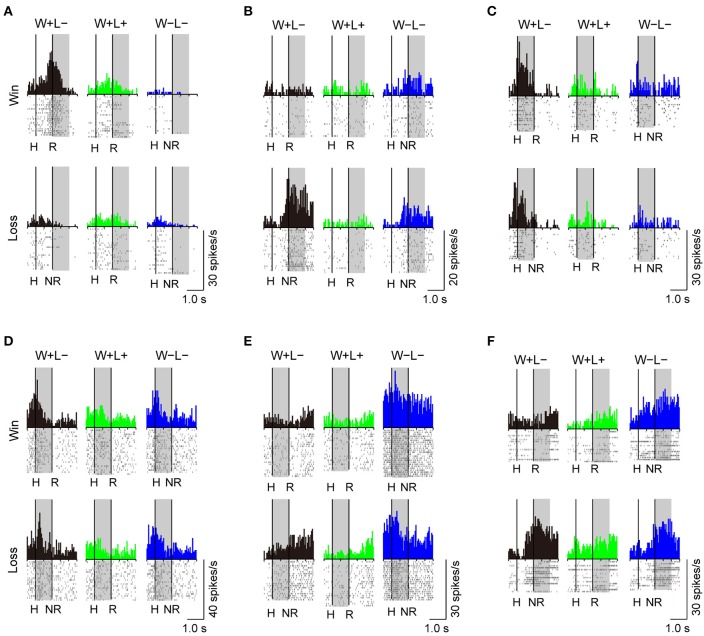
Examples of LPFC neurons that showed differential activity depending on the trial type. (A) positive Win/Lose x Black, (B) negative Win/Lose x Black, (C) positive Black, (D) negative Green, (E) positive Blue, and (F) negative Reward type neurons (“positive” and “negative” indicate neurons with positive and negative beta values, respectively. See Materials and Methods). The left vertical line in each display indicates the time of a hit by either monkey. The right vertical line indicates either the time of a reward delivery (reward trials) or 1 s after a hit (no-reward trials). Each shaded area indicates the period when the typical activity of each type was observed. H, Hit; R, reward delivery; NR, 1 s after a hit.